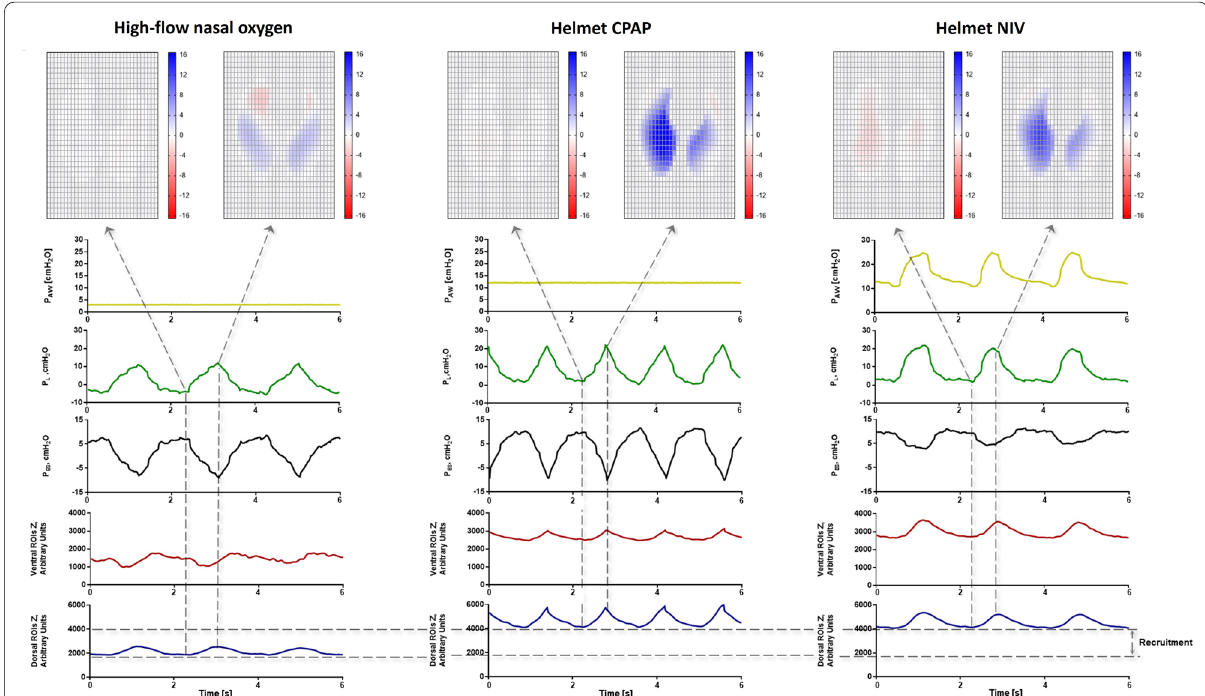
Fig. 1 Comparison of representative tracings of airway pressure, transpulmonary pressure esophageal pressure and global and regional electrical impedance tomography during spontaneous breathing with high-flow nasal, helmet CPAP and NIV in a patient with severe hypoxemic respiratory failure. The left panel shows the respiratory mechanics during spontaneous breathing with high flow oxygen mask. Due to the high inspiratory effort and to the inhomogeneity of the lung, it is possible to appreciate the Pendelluft effect. The start of inspiration (marked by the initial negative deflection of the Pes) is coincident with the increase of electrical impedance tomography in the Global ROI tracing (∆Z, %). However, while in the dorsal regions of the lungs (dependent regions) there is an increase of ∆Z%, in the ventral region there is a decrease of ∆Z% (non-dependent regions). This represents the “Pendelluft effect”, an intra-tidal displacement of air from non-dependent to dependent lung regions, causing local overstretch of the latter. The first dotted line marks the moment when the ∆Z% signal in the most ventral ROI stops decreasing and local inflation begins. In right panels, the respiratory mechanics of the same patient receiving helmet CPAP and pressure support are shown. High PEEP generates recruitment in dorsal lung regions and mitigate the pendelluft effect and enhances more homogeneous lung inflation. Presence of pressure support causes a decrease of the inspiratory effort ∆Pes swing. Heat maps describe lung regional inflation (blue pixels) and deflation (red pixels). In the absence of PEEP, a significant pendelluft effect is documented (red pixels during inspiration), which reflects the intra-tidal shift of gas from anterior non-dependent lung regions to posterior dependent lung regions. This is abolished by high PEEP delivered through the helmet interface, which makes inflation homogenous across the whole lung tissue. Acronyms: PAW, airway pressure; PES, esophageal pressure; ∆Z %, electrical impedance tomography signal variation; ROI, region of interest; VV, ventral-ventral; MV, middle-ventral; MD, middle-dorsal; DD,